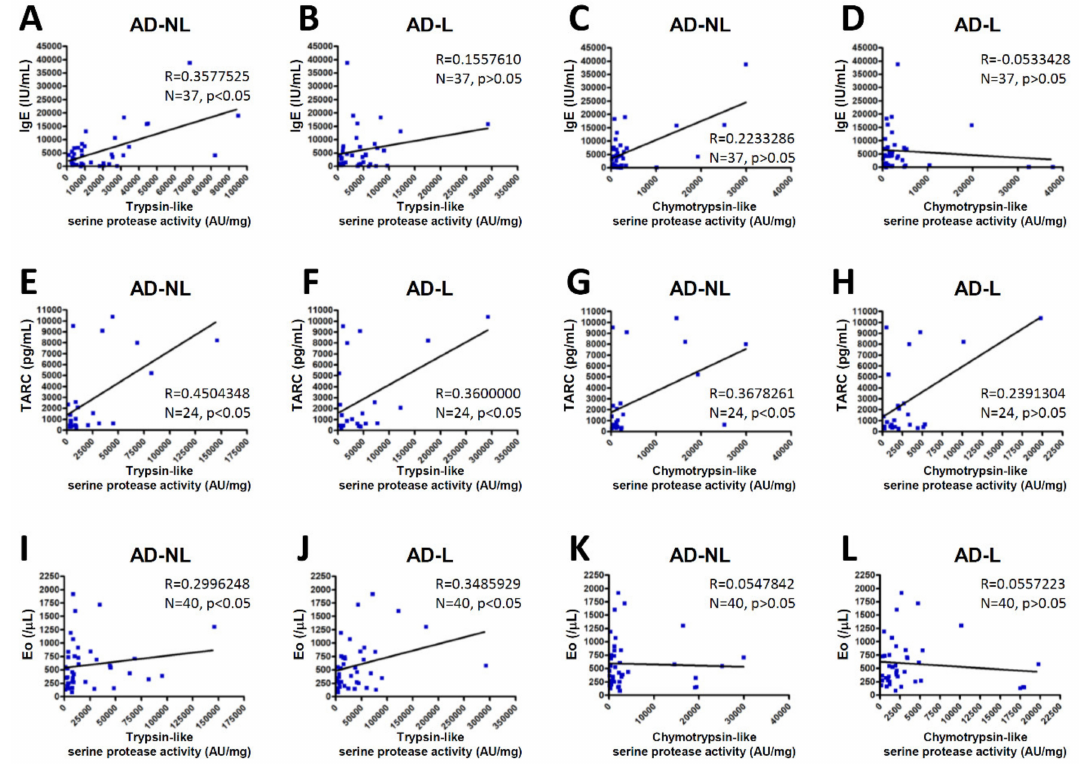
Figure 3. The correlations between serine protease activity in the SC and biomarkers of AD. The correlations between trypsin- or chymotrypsin-like serine protease activity in non-lesions (AD-NL) or lesions (AD-L) and the serum total IgE levels ( A – D ), serum TARC levels ( E – H ) and the peripheral blood eosinophil counts (Eo) ( I – L ) of the AD patients were analyzed by Spearman’s rank correlation coe ffi